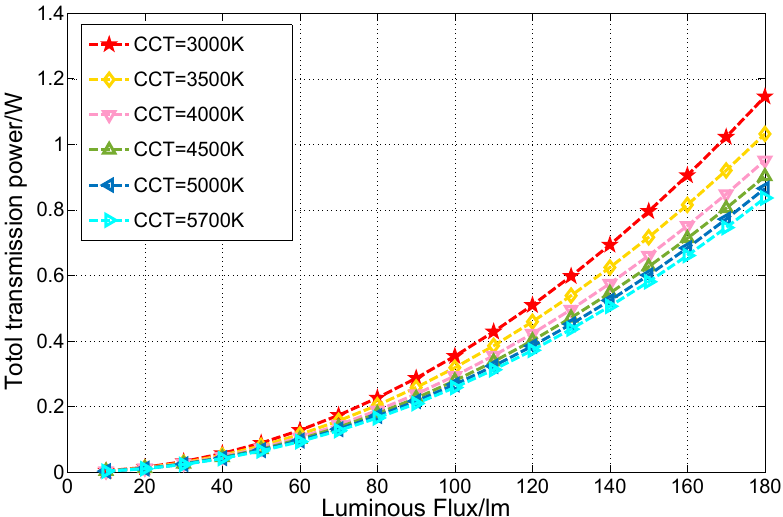
Figure 6. Total transmission power comparison for the proposed optimal power allocation strategy under different CCT values with interference coefficient τ =